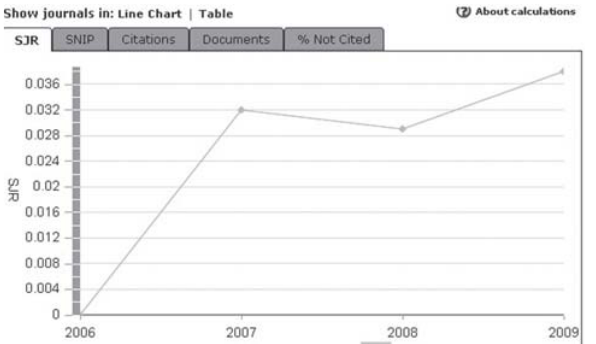
Fig. 1 - Gráfico mostrando aumento do número de citações da RBCCV na Base de Dados Scopus entre 2006 e